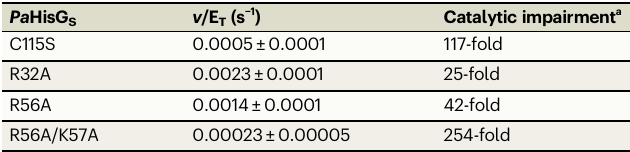
a Ratio of v /E T forWT- Pa HisG S (0.0586±0.0002)to v /E T reported here.